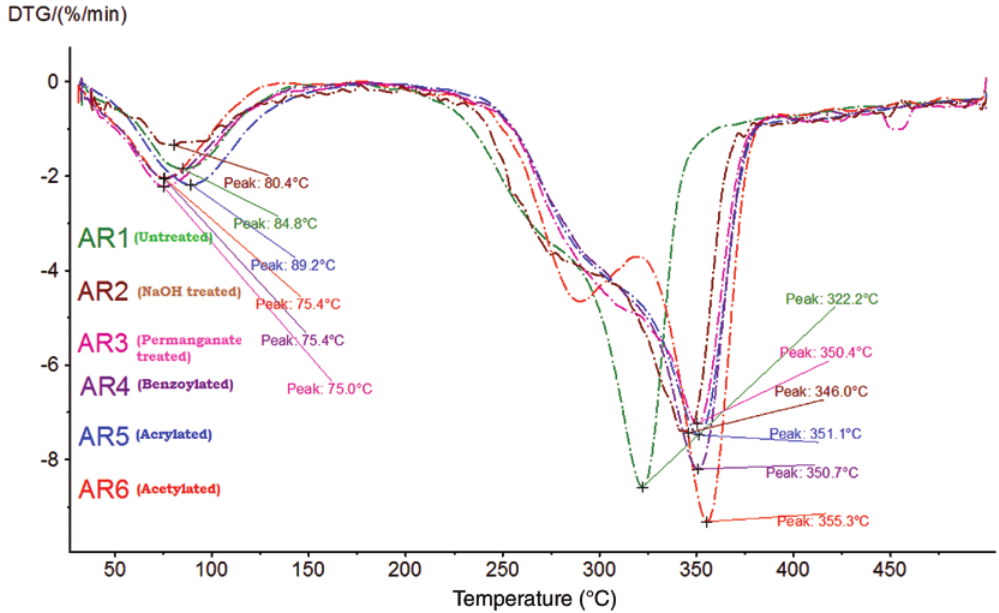
Figure 7: Derivative thermogravimetric (DTG) analysis of untreated and all chemically treated areca